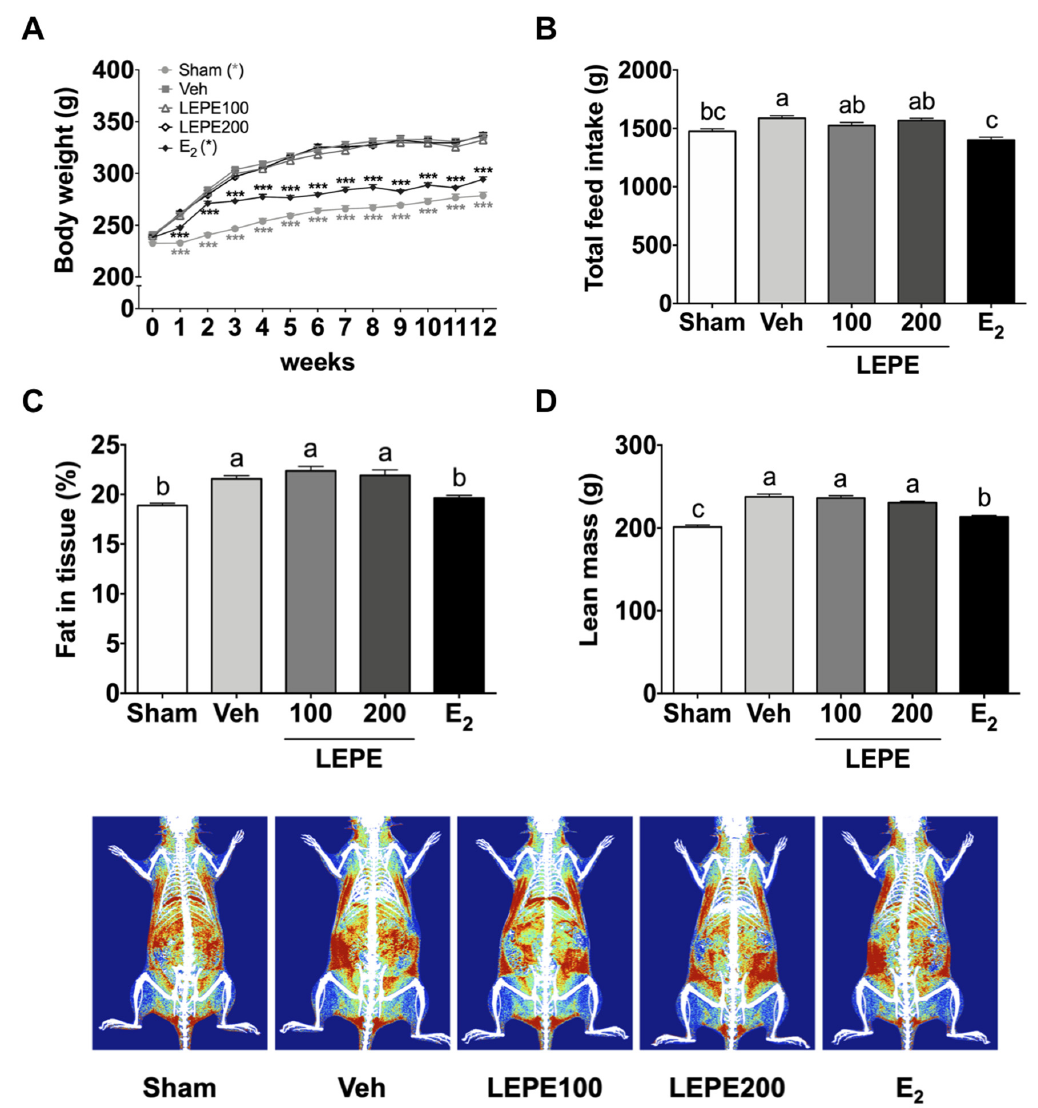
Figure 1. Growth performance and body composition in the ovariectomized rat model of menopause supplemented with LEPE. ( A ) Body weight, ( B ) total feed intake, ( C ) whole-body fat in tissue, and ( D ) lean mass. Sham, control sham-operated rats; Veh, ovariectomized (OVX) rats treated with vehicle; LEPE100, OVX rats treated with Leonurus japonicus Houtt, Eclipta prostrata L., and Pueraria lobata Ohwi extract (LEPE) 100 mg/kg bw; LEPE200, OVX rats treated with LEPE 200 mg/kg bw; E 2 , positive control, OVX rats injected with estradiol 3.0 μ g/kg bw. Data are shown as mean ± SEM ( n = 12). a–c Significant differences were analyzed by one-way ANOVA with Tukey’s multiple comparisons between groups ( p < 0.05). *** p < 0.001 indicates a significant difference compared to the vehicle group.